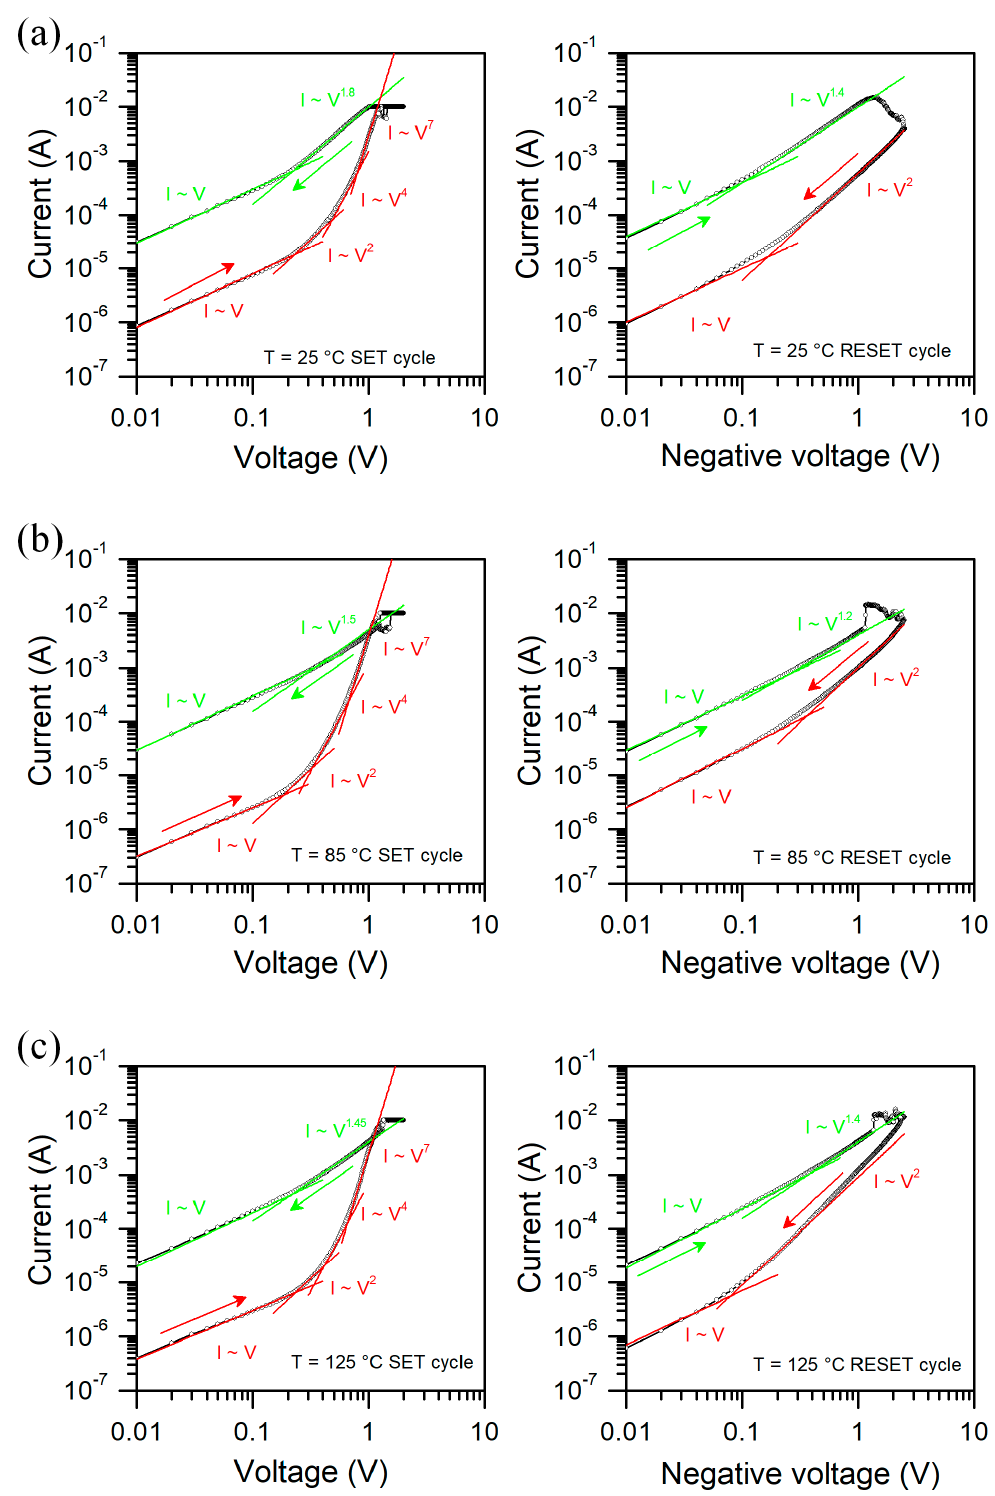
Figure 10. Current-voltage characteristics of Al/SiO 2 /n++-Si RRAM device with fitted slope curves at various temperatures, ( a ) 25 °C, ( b ) 85 °C and ( c ) 125 °C.